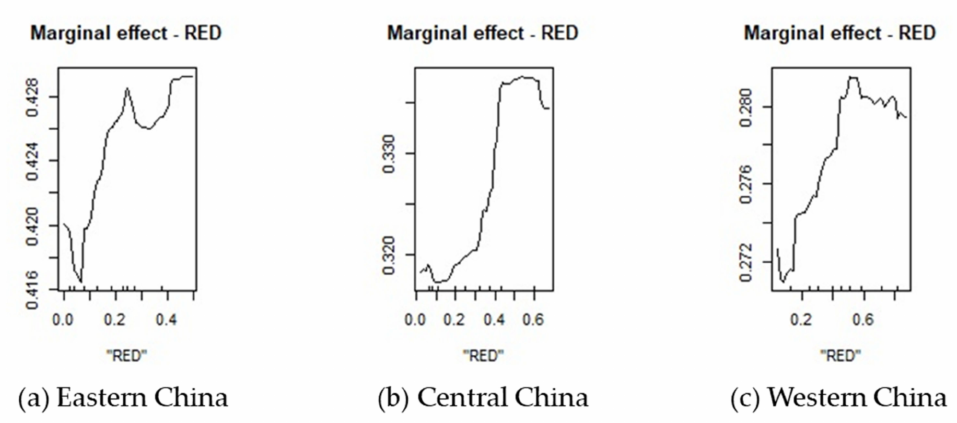
Figure 9. The marginal effect curve of RED in eastern, central, and western China. Note: Figure ( a – c ) are marginal effect curves of RED on the carbon emission efficiency in eastern, central, and western China